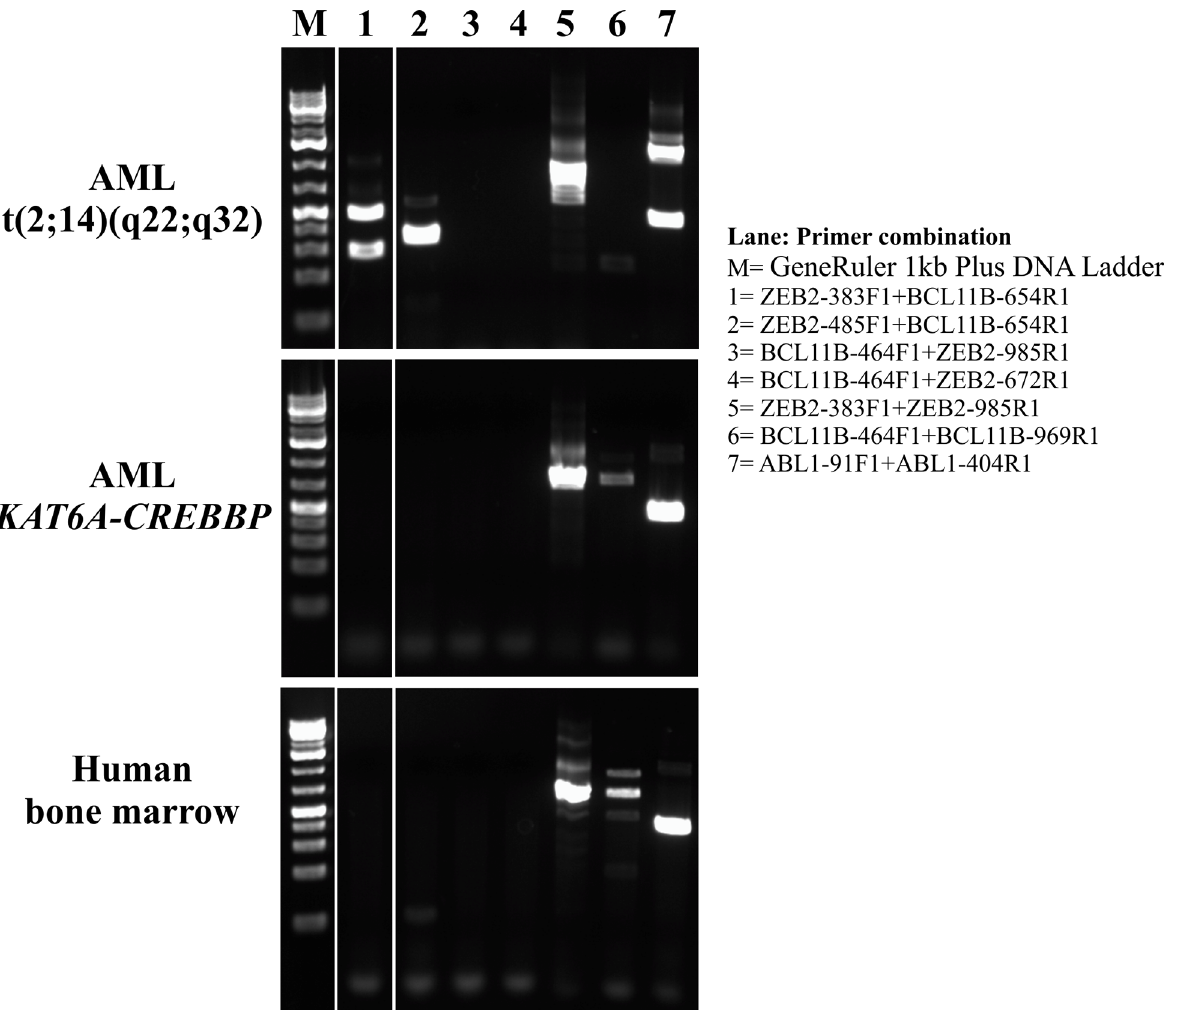
Fig 2. RT-PCR amplification. Gel electrophoresis for the ZEB2-BCL11B , BCL11B-ZEB2 , ZEB2 , BCL11B , and ABL1 cDNA transcripts of AML patient with t (2;14), control AML patient with KAT6A-CREBBP fusion, and normal bone marrow.